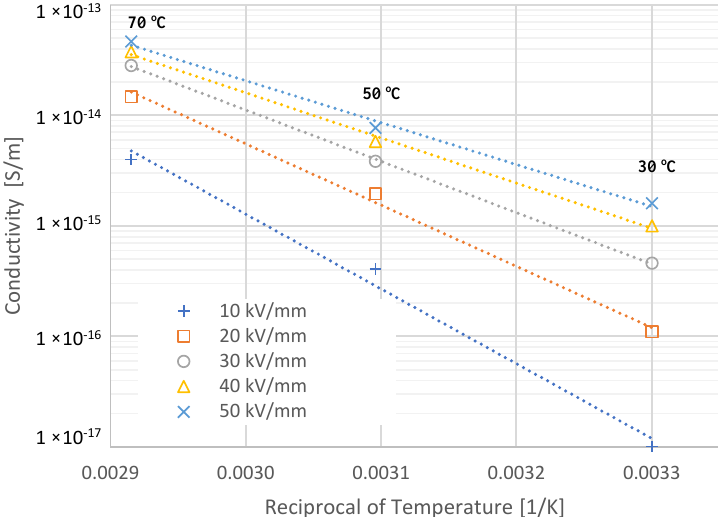
Figure 6. Arrhenius plot of DC conductivity for the copolymer blend; each curve corresponds to the electric field given in the legend.